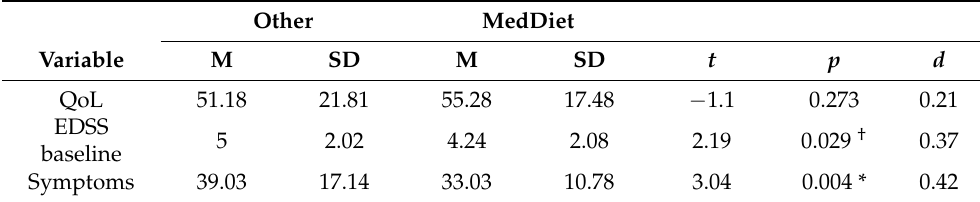
Table 5. Two-tailed independent samples t -test for QoL, EDSS, and Symptoms by MedDiet and